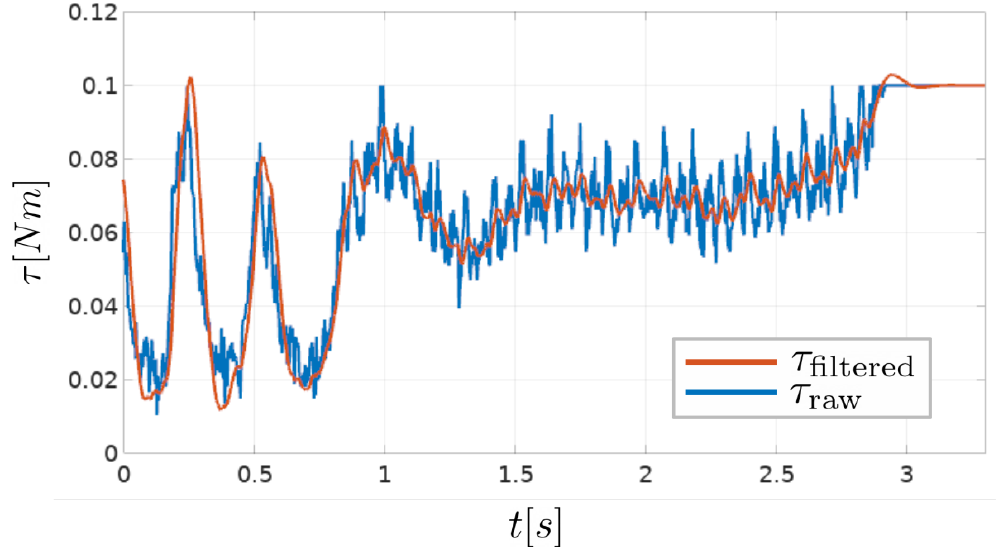
Figure 4. Raw torque signal calculated from current measurements ( τ raw ), and the filtered torque signal, output from the alpha–beta filter ( τ filtered